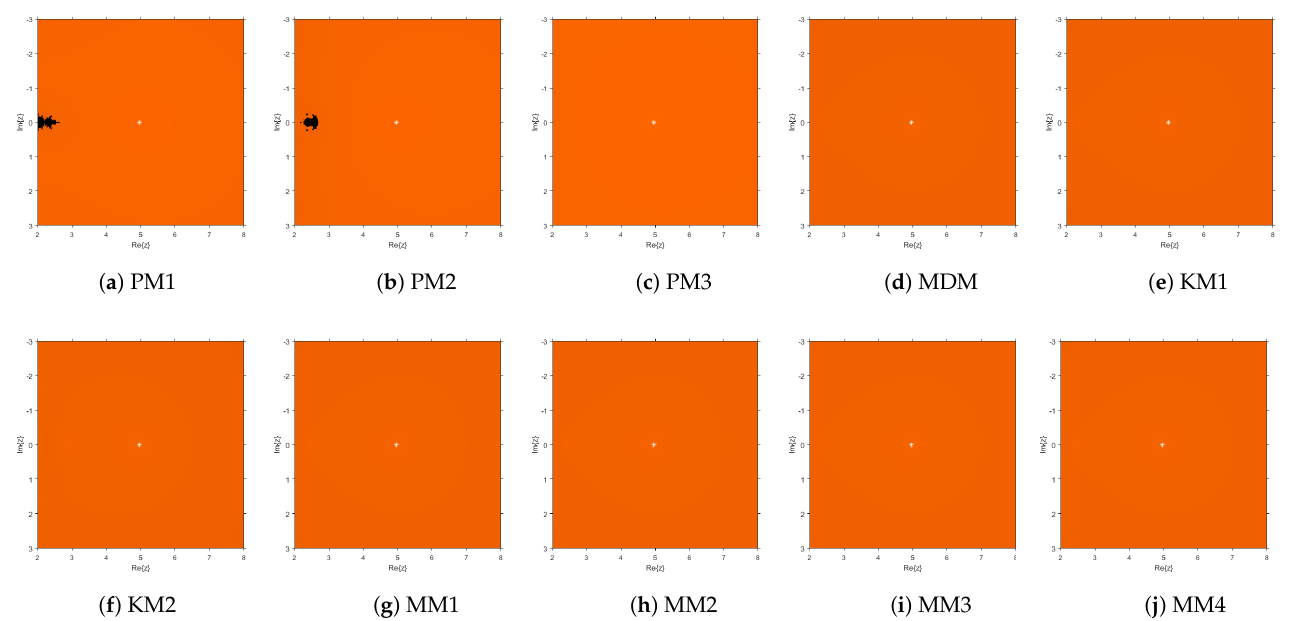
Figure 3. Basins of attraction of new and existing methods for Example